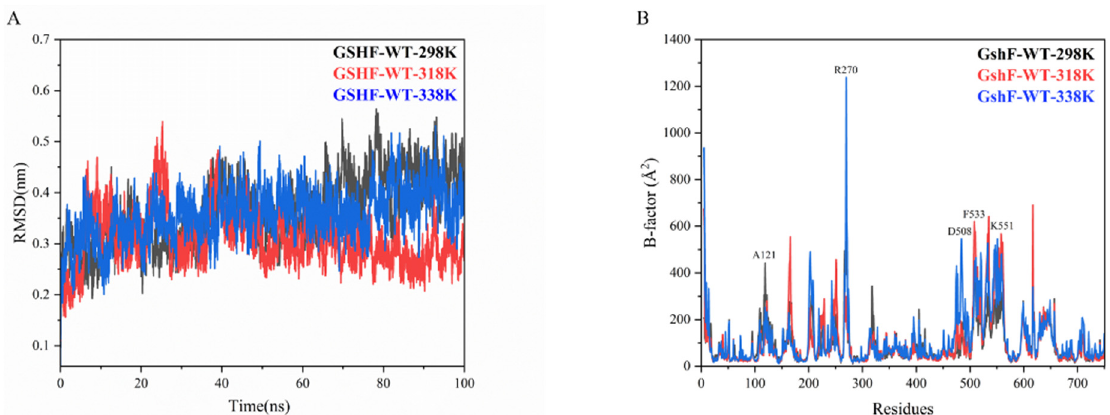
Figure 2. The RMSD and B-factor values of GshFSA. ( A ) The RMSD values of GshFSA-298 K, GshFSA-318 K and GshFSA-338 K; ( B ) The B-factor values of GshFSA-298 K, GshFSA-318 K and GshFSA-338 K.